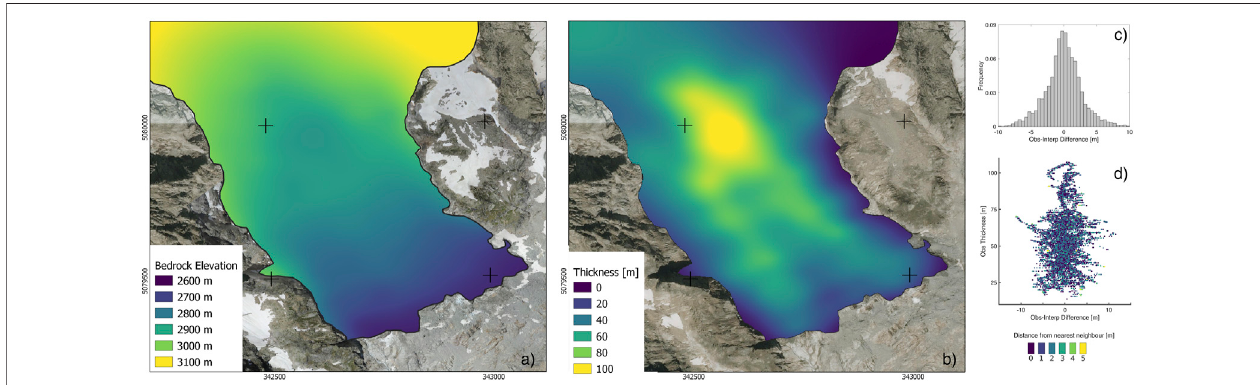
FIGURE4|(A,B) Bedrockelevationandglacierthickness,respectively,obtainedfromtheinterpolationoftheGPRpro fi lesacquiredon7July2020. (C) Frequency distributionofthedifferencebetweenGPRthicknessmeasurementandinterpolatedvalues. (D) Measuredandinterpolatedthicknessdifferencevs.measuredthickness, the color denotes the distance from the nearest interpolating